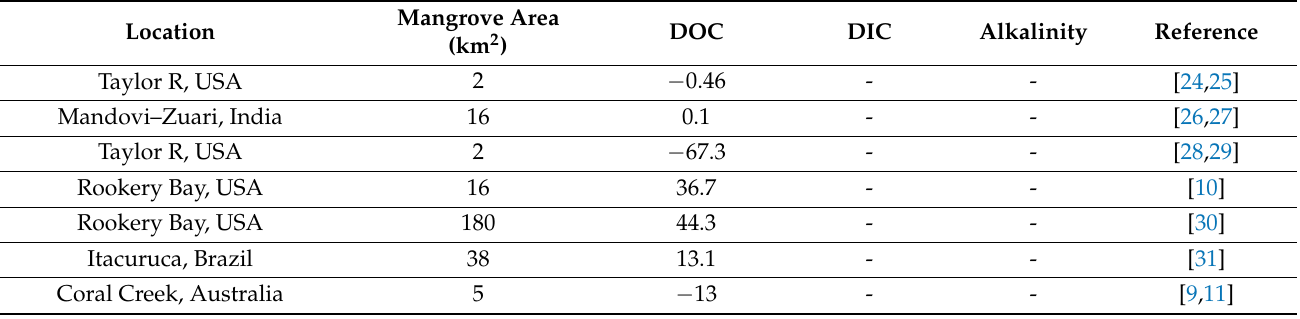
Table 1. Rates of porewater DOC, DIC and alkalinity flux from mangroves ecosystems